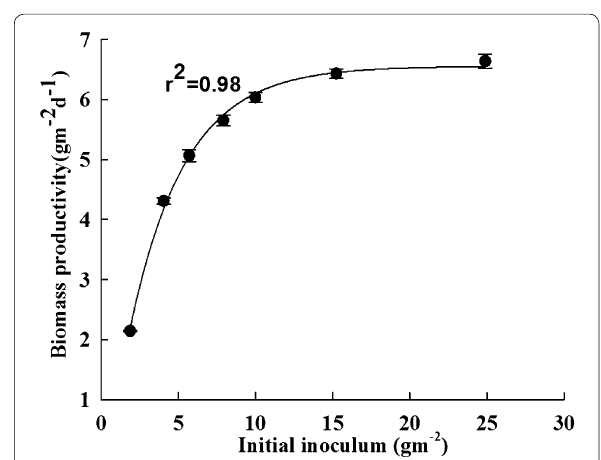
Fig. 2 Effect of inoculum density on growth of B. braunii SAG807‑1 under attached cultivation. Data are means three replicates